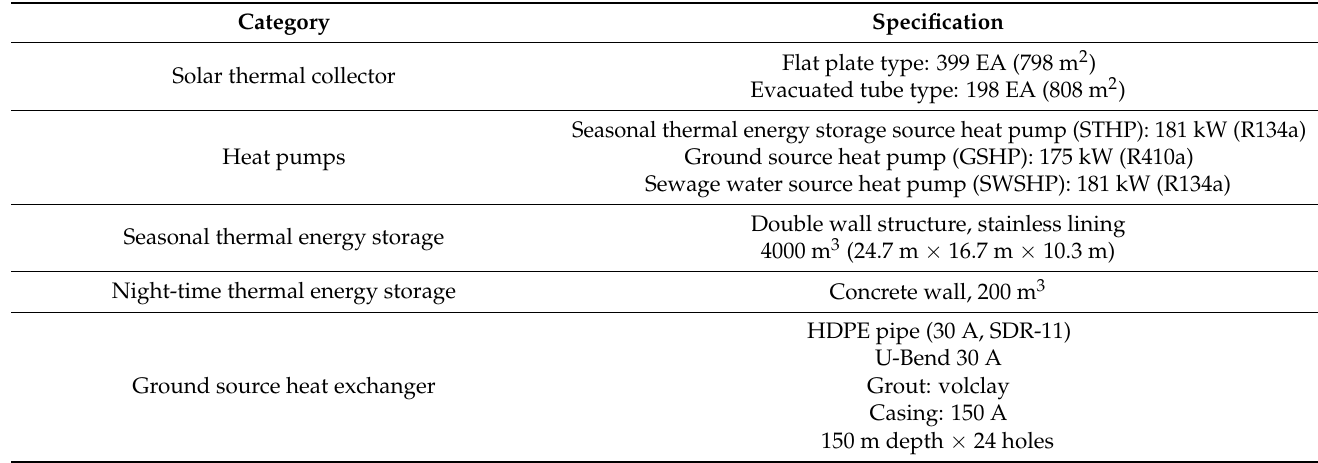
Table 1. Specification of components of the hybrid renewable energy systems.